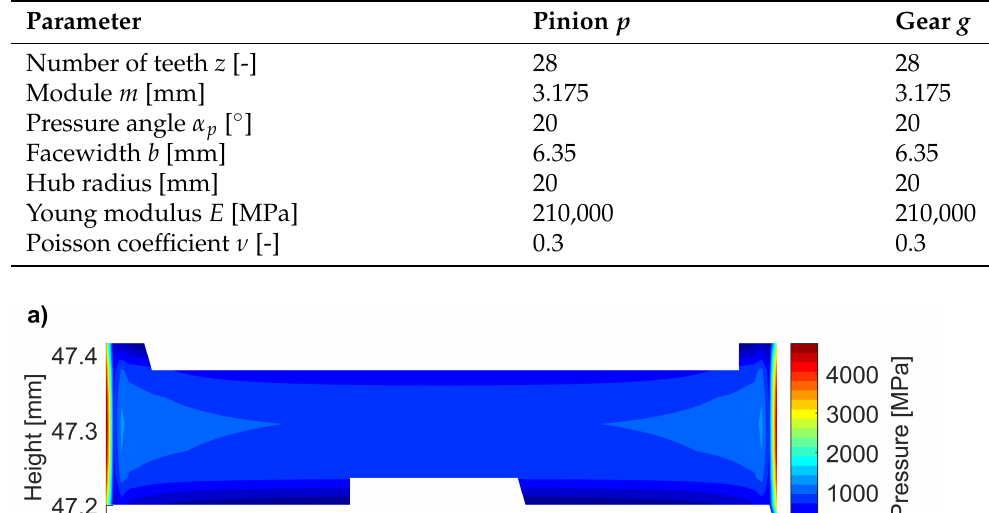
Table 3. Gear pair parameters.